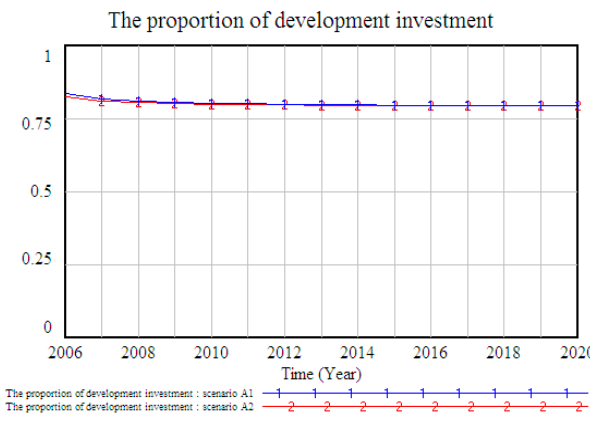
Figure 5. The proportion of exploration investment.